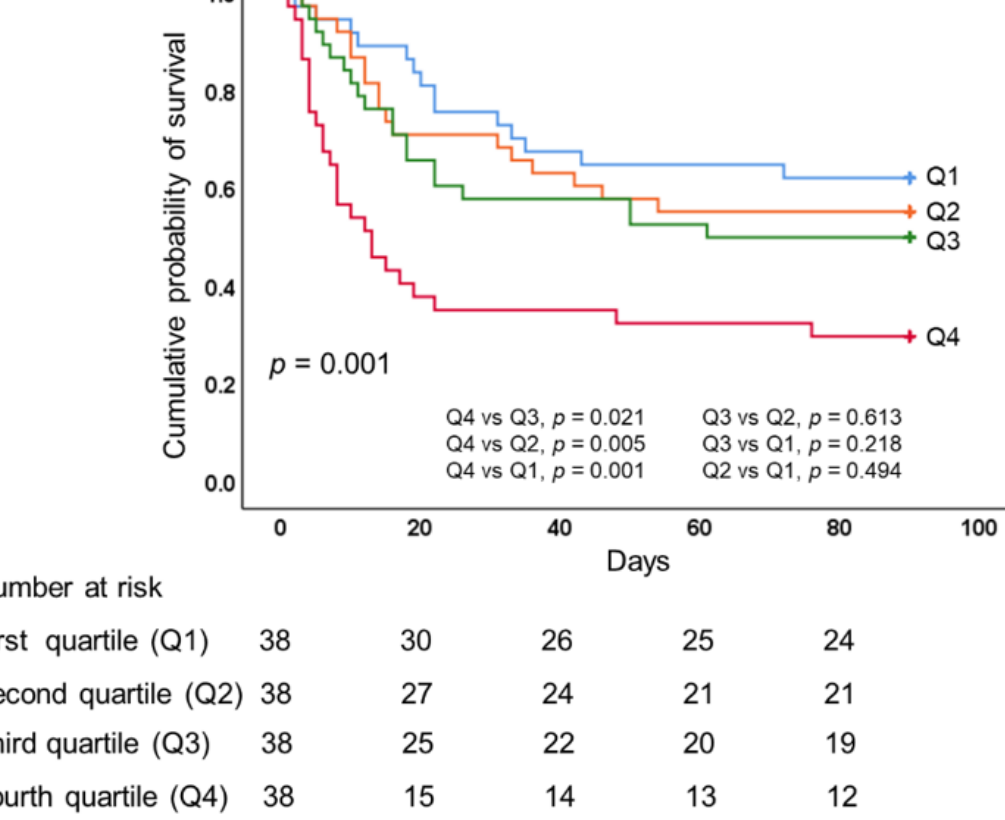
Figure 3. Kaplan–Meier 90-day survival curves of patients undergoing ECMO for severe acute respiratory distress syndrome, as stratified by quartiles of cumulative fluid balance during the first 3 days of ECMO. ECMO, extracorporeal membrane oxygenation.